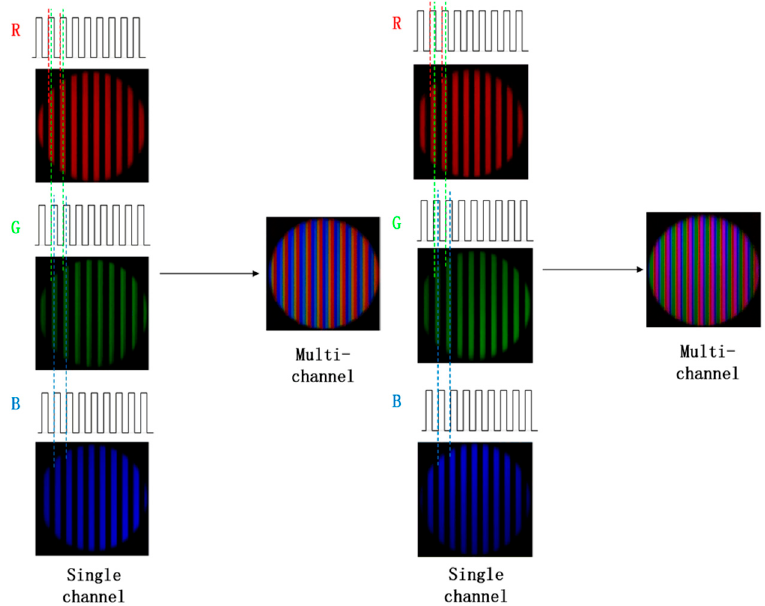
Figure 3. The effect of different phases.